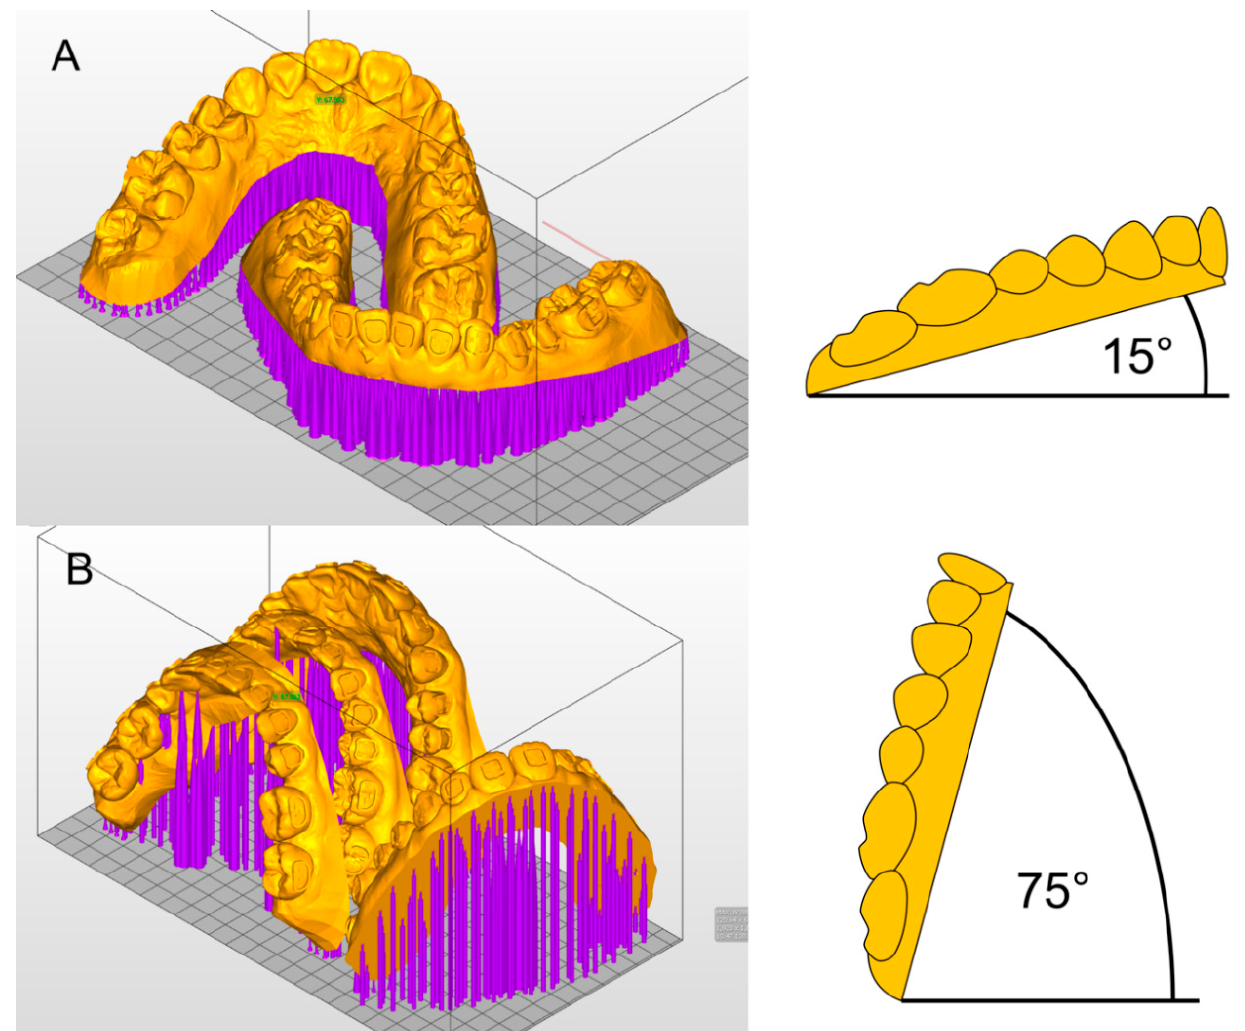
Figure 3. Printing orientation in ( A ) Group H and ( B ) Group V in Asiga MAX™ printer software (Asiga Composer, Scheu Dental, Iserlohn) and model angulations.